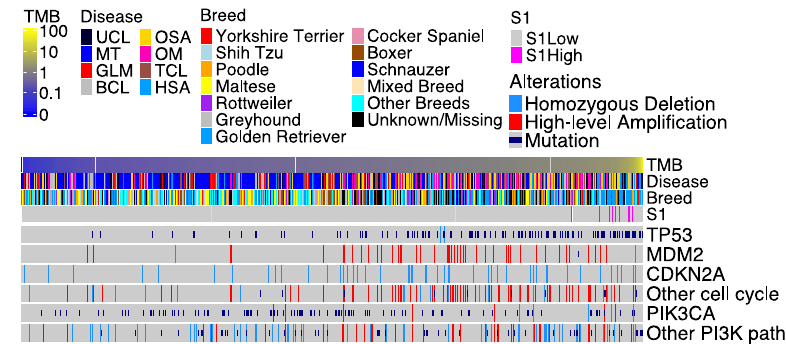
Fig. 5 We investigated TMB and common alterations in each of the 597 tumors of over 7 tumor types and over 35 breeds. The tumors in the oncoprint were ordered from left to right by lowest to highest TMB. Seven tumor types as indicated in Fig. 3 and unknown tumor types (UCL; see Fig. 1) are included. Breeds shown include those validated, corrected, predicted or unknown (with an issue or not predicted) as shown in Fig. 2, as well as other breeds, which are not validated due to small sample size, and mixed breeds. Top recurrent gene and pathway alterations are shown. Source data are provided as a